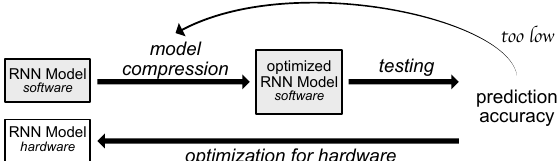
Figure 7. Design flow for hardware implementation. c (cid:13) 2018 IEEE. Reprinted, with permission,